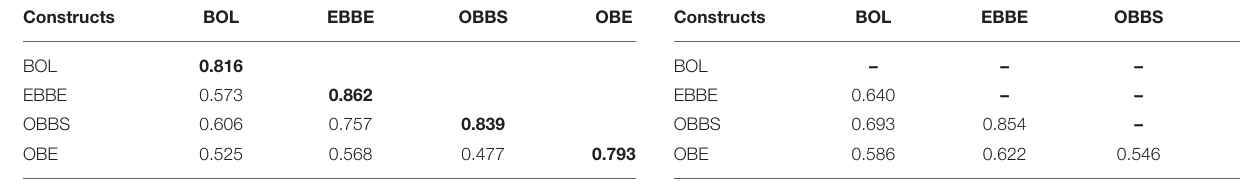
TABLE 3 | Discriminant validity (Fornell–Larcker-1981 Criteria). Constructs